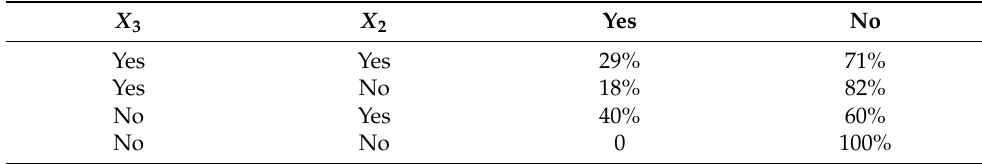
Table A7. Conditional probability distribution of M 2